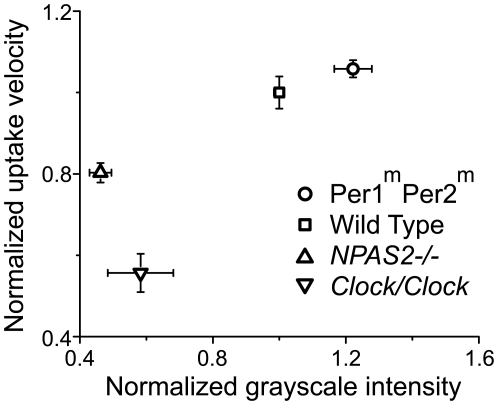
Higher glutamate uptake is associated with higher GLAST immunofluorescence.Scatter plot shows the relationship between glutamate uptake and grayscale intensity of GLAST immunofluorescence. Data normalized to wild type levels (wild type: n = 7; NPAS2−/−: n = 6; Per1mPer2m: n = 4; Clock/Clock: n = 2, mean±SEM).